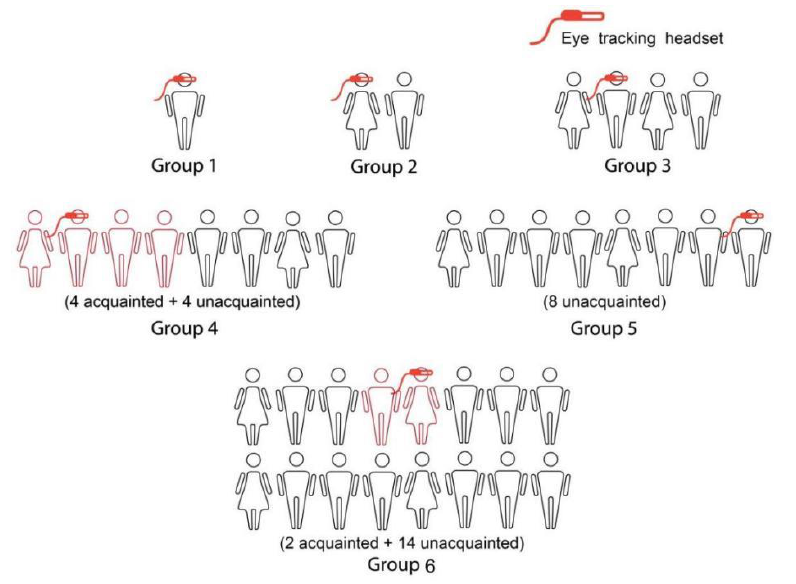
Figure 1. An example of composition of each group form: acquainted participants are illustrated in red line; in each group, one participant was selected to wear the eye movement tracking headset.